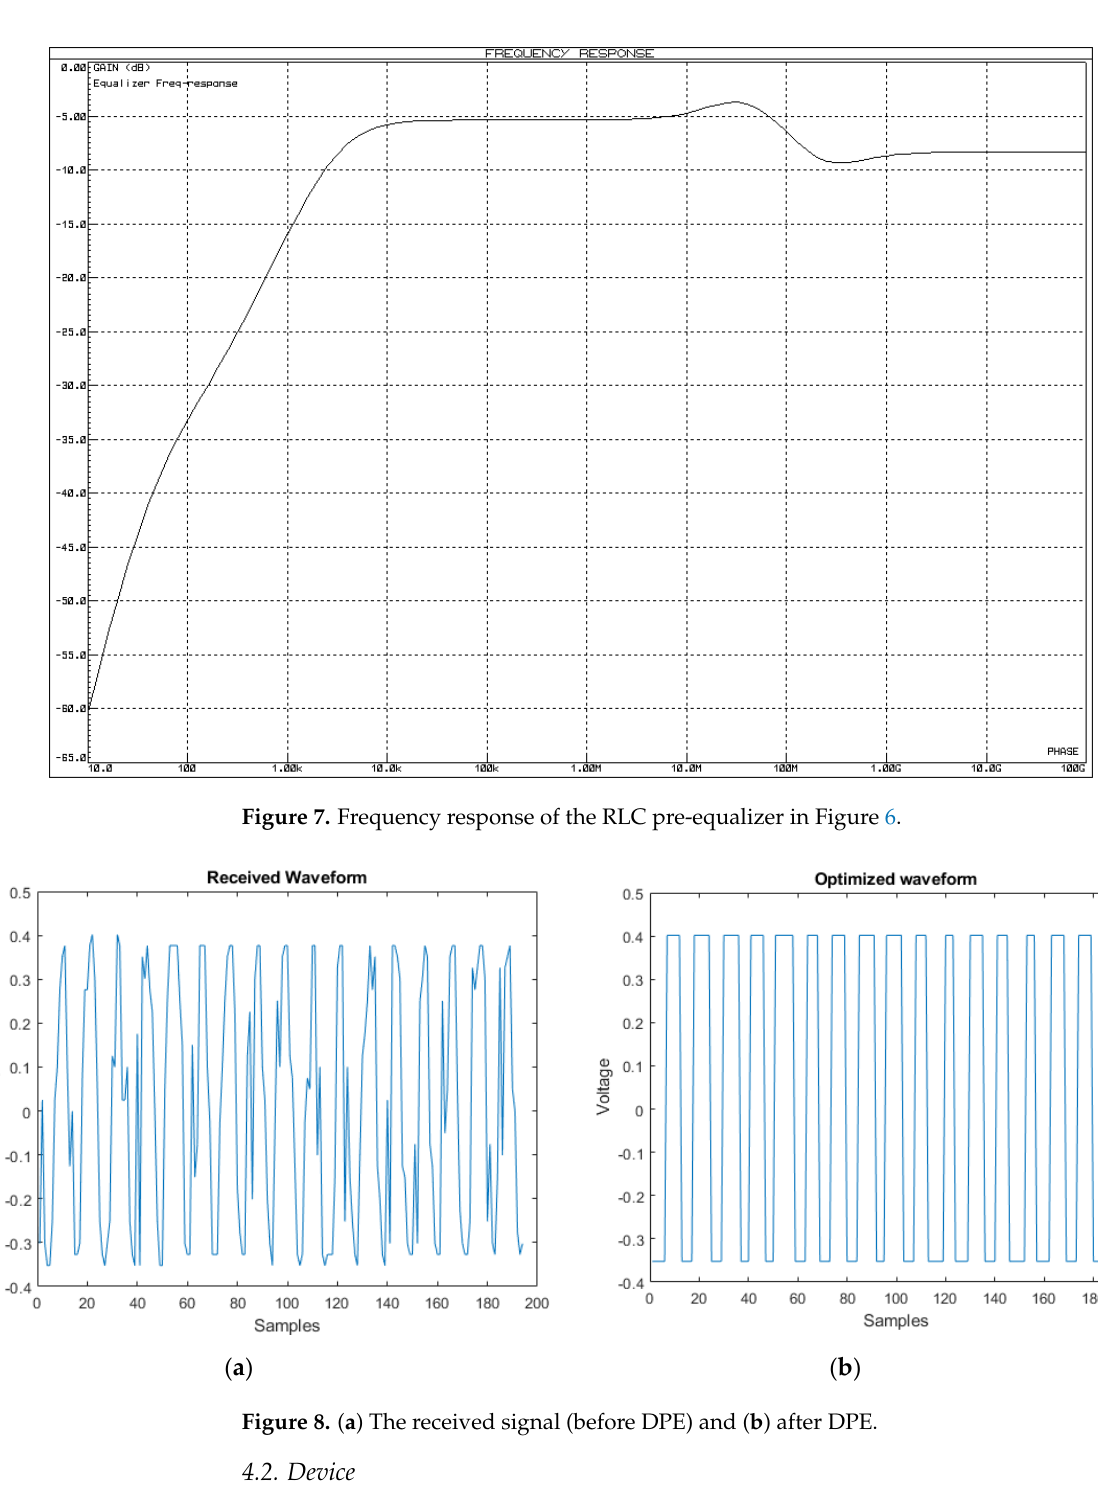
Figure 8. ( a ) The received signal (before DPE) and ( b ) after DPE.